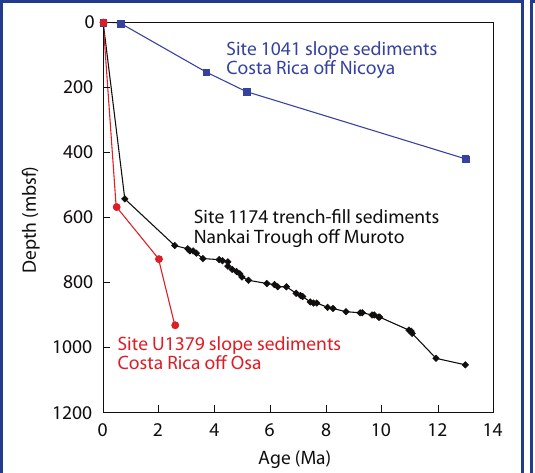
Figure 6. Comparison of sediment accumulation rates calculated from IODP Site U1379, and ODP Sites 1041 and 1174.